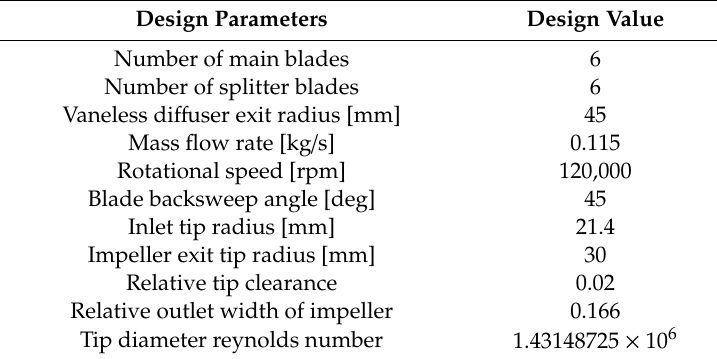
Table 1. Centrifugal compressor major geometry parameter.